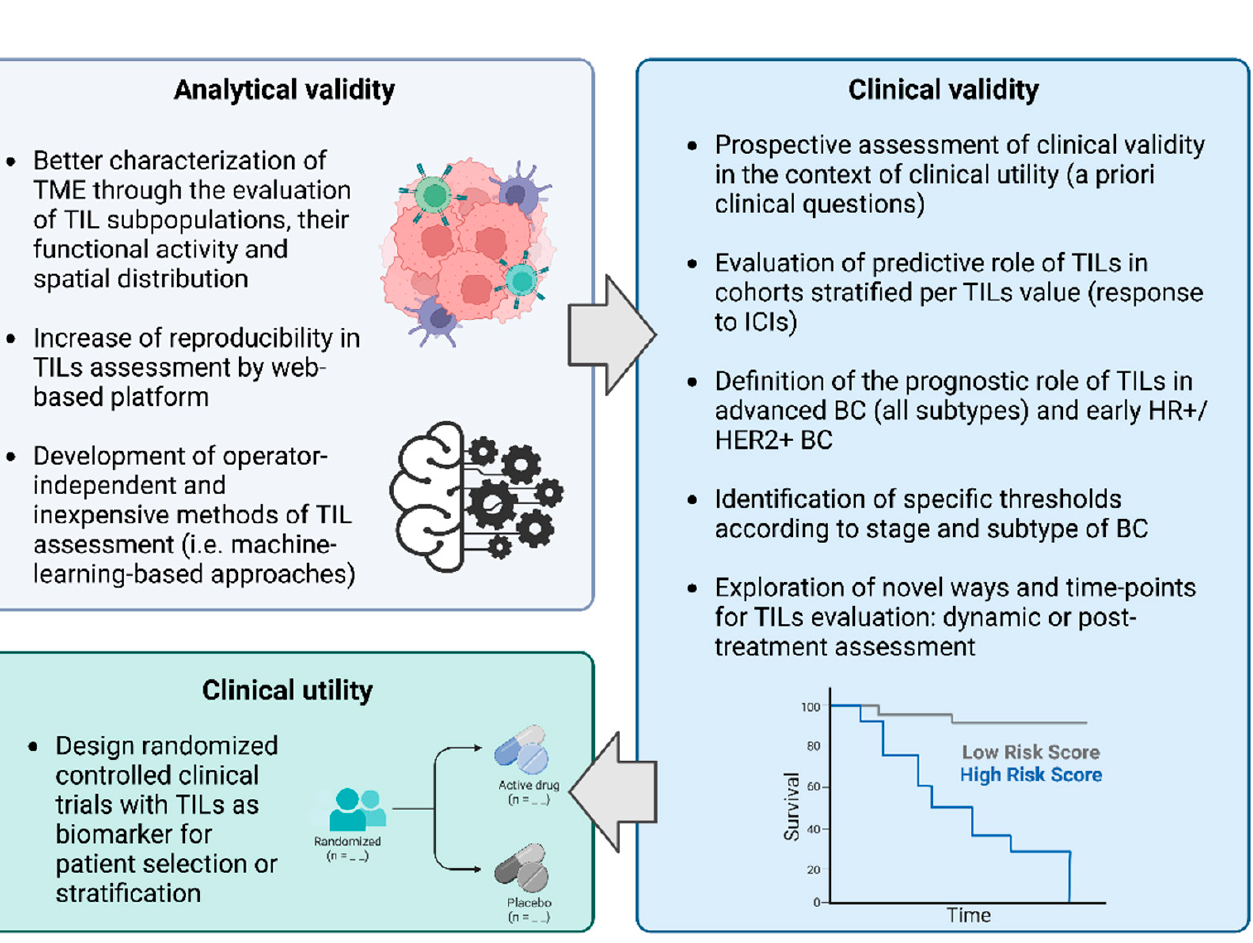
Figure 1. Current issues for the assessment of the analytical validity, clinical validity, and clinical utility of TILs in BC. Keys: BC, breast cancer; HER2, human epidermal growth factor receptor 2; HR, hormone receptor; ICIs, immune checkpoint inhibitors; TILs, tumor-infiltrating lymphocytes; TME, tumor microenvironment. Created with BioRender.com (accessed on 20 October 2022).